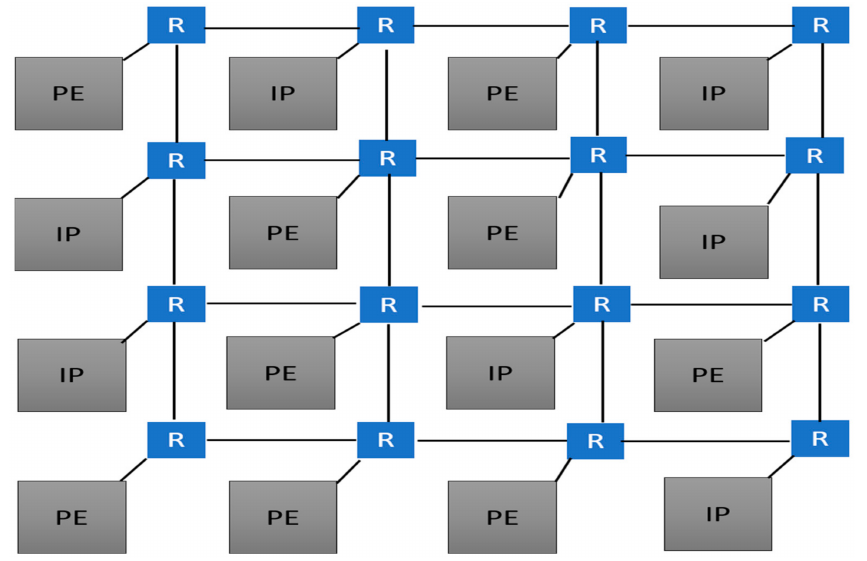
Figure 1. Mesh NoC